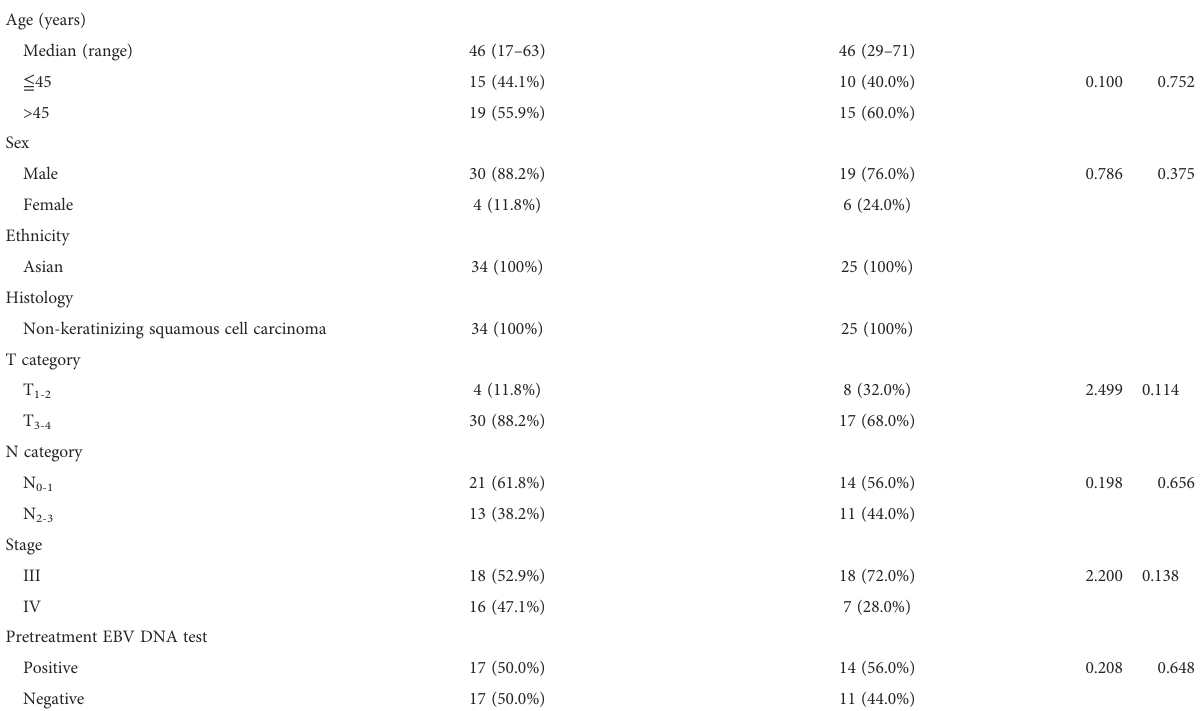
TABLE 1 Baseline